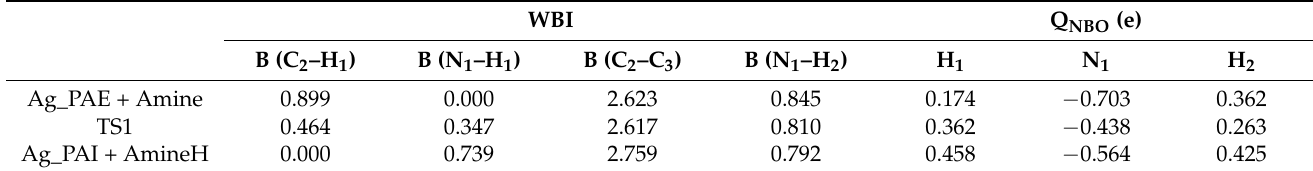
Table 2. WBI and Q NBO values for hydrogen migration reaction pathway involving